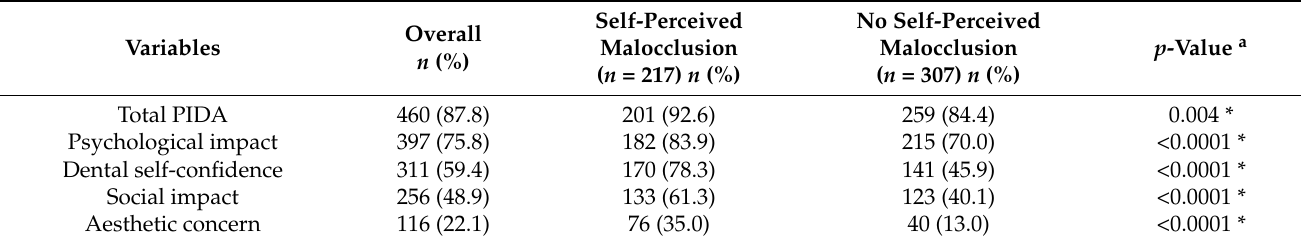
Table 2. Summary on the prevalence of Psychosocial Impact of Dental Aesthetics (PIDA) in the sample ( N = 524).